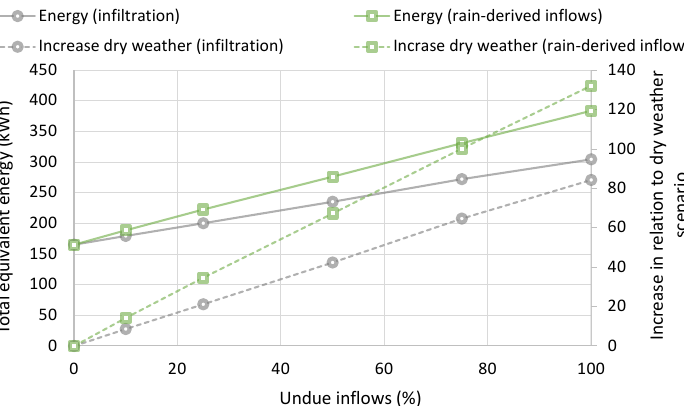
Figure 9. Total equivalent energy consumption for the different UI scenarios.